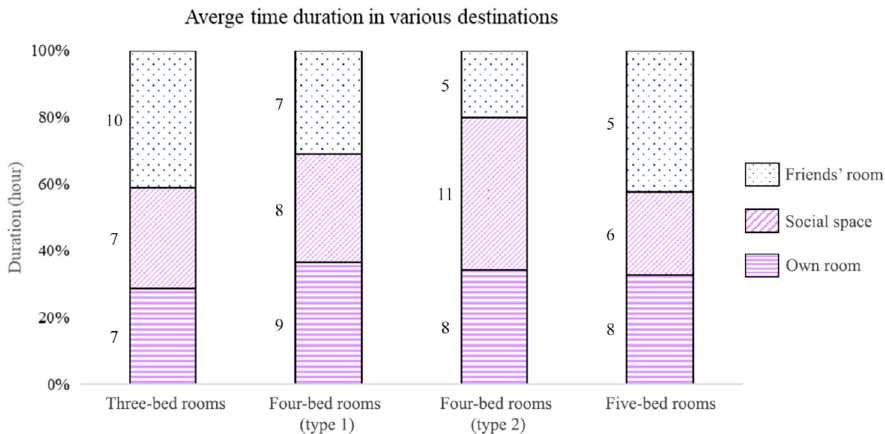
Figure 7. Individual movement patterns show that residents returned to their bedrooms regularly throughout the day. Purple squares mean that residents were located to be in their own bedrooms at a given hour while white squares represent residents were out of their rooms. For instance, residents of three-bed rooms did not go back to their bedrooms as often when compared with residents of other room types.